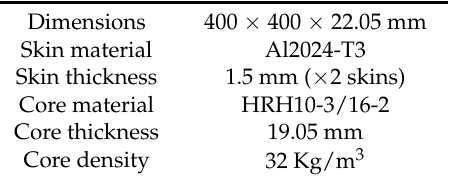
Table 2. Dimensions and mechanical characteristics of the sandwich panel.